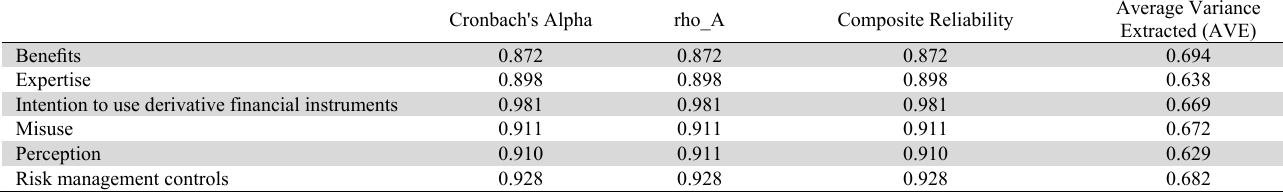
Construct Reliability and Validity